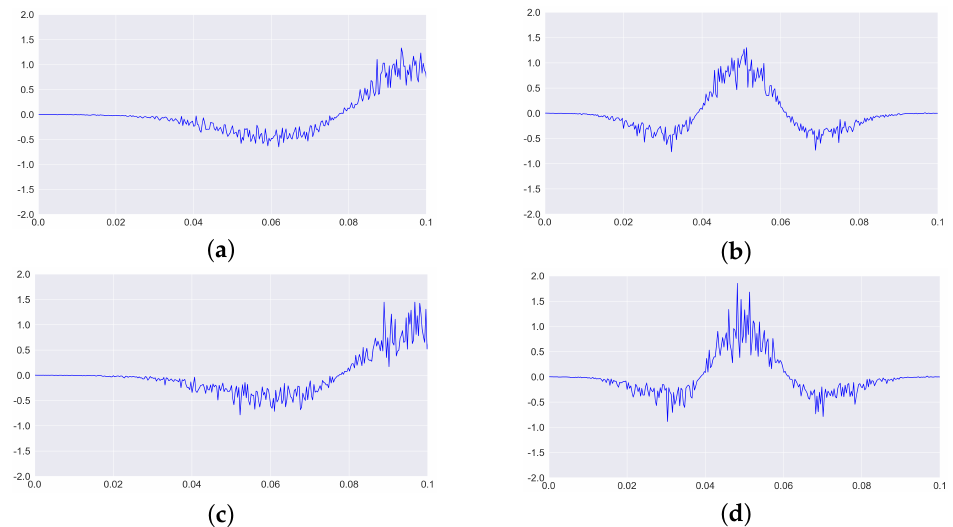
Figure 2. Test 1. Inverse problem I. Reconstruction result after 2000 iterations (noisy data). Level of noise is 5% (graphs ( a , b )) and 10% (graphs ( c , d )). Graphs ( a , c )—reconstruction of the function r 1 ( t ) ; Graphs ( b , d )—reconstruction of the function r 2 ( t ) . Green lines—true solution, red lines— computed